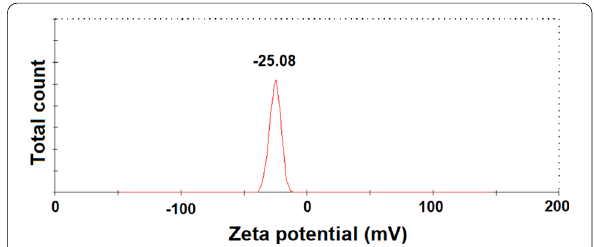
Fig. 4 Zeta potential of ZnONPs synthesized by the fungus A.